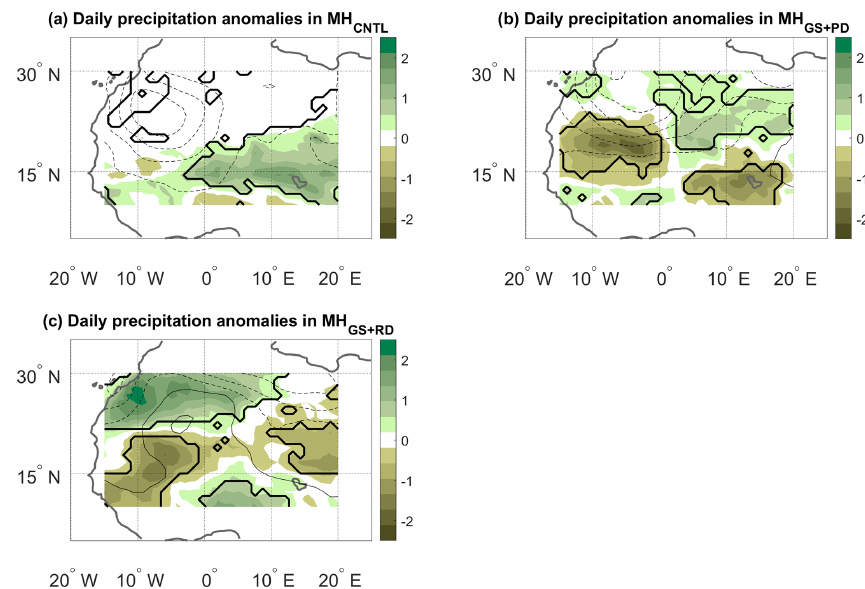
Figure A6. The same as Fig. 6 but using the domain 10–30 ◦ N, 15 ◦ W–20 ◦ E. The contour lines have an interval of 0.25hPa and span the following ranges: (a) − 0.25 to − 1.25hPa, (b) 0 to − 1.5hPa, and (c) + 0.25 to −